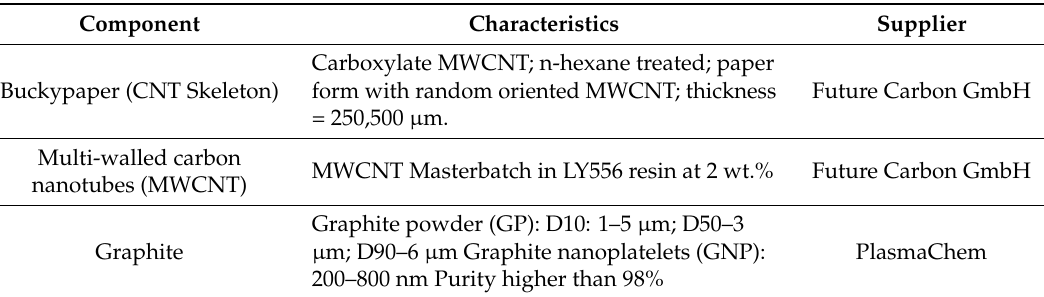
Table 6. Fillers characteristics and